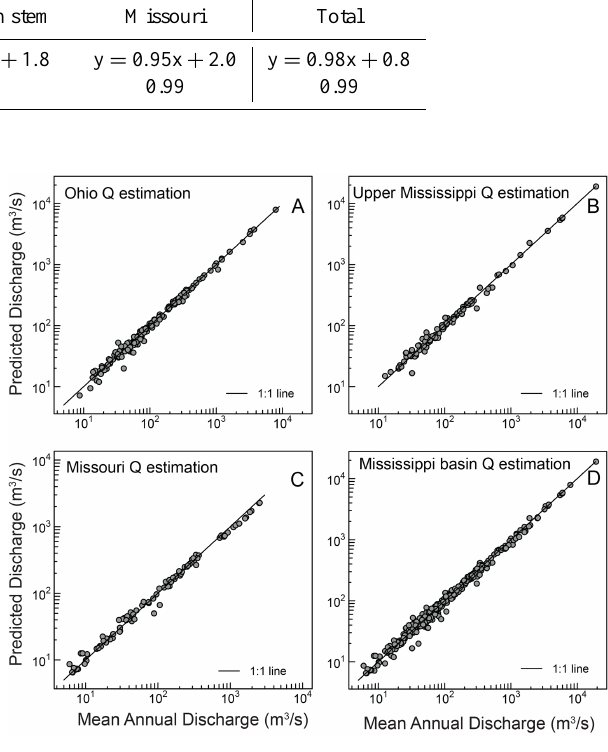
Figure 9. Estimated and USGS-measured mean discharges for 346 gauging stations in the Mississippi